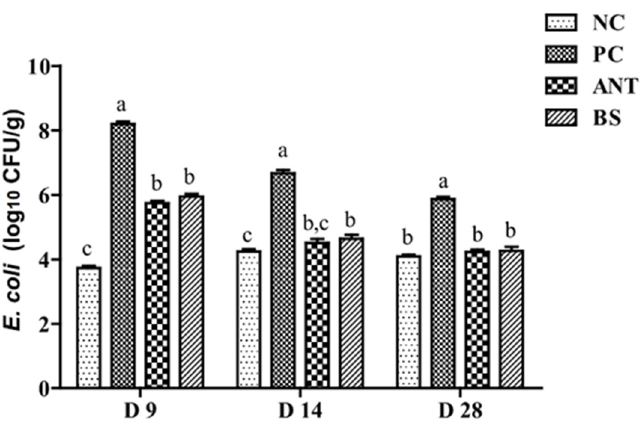
Figure 2. Effect of B. subtilis on the quantity of E. coli in the cecum of ducks challenged with E. coli . NC–negative group, basal diet without E. coli challenge. PC–positive group, basal diet with E. coli challenge. ANT–antibiotic group, basal diet + virginiamycin (30 mg/kg) with E. coli challenge. BS– basal diet + 2.5 × 10 9 CFU/kg B. subtilis with E. coli challenge. Data are indicated as means ± SEM. a,b,c Values, for the same day, with different superscripts are significantly different ( p < 0.05). The individual duck in each replicate was the experimental unit ( n = 6).